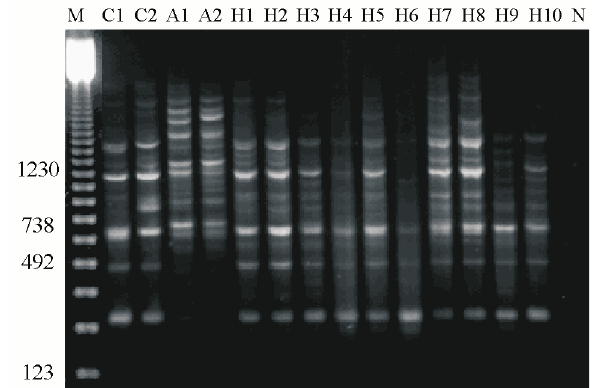
Figure 1 - Products of amplification by the SPAR technique, representing micro 13 patterns. M = standard molecular marker (123 pb DNA ladder, GibcoBRL); C1 and C2 = C. idella , female; A1 and A2 = A. nobilis , male; H1 to H10 = interspecific hybrids; N = negative